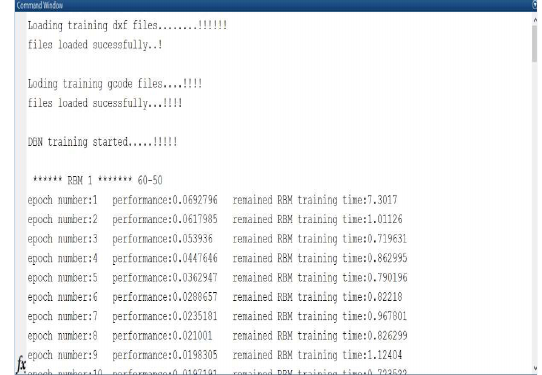
Fig.9. Screenshots of execution of code in MATLAB (holes) Fig.10. Screenshots of execution of code in MATLAB (counter-